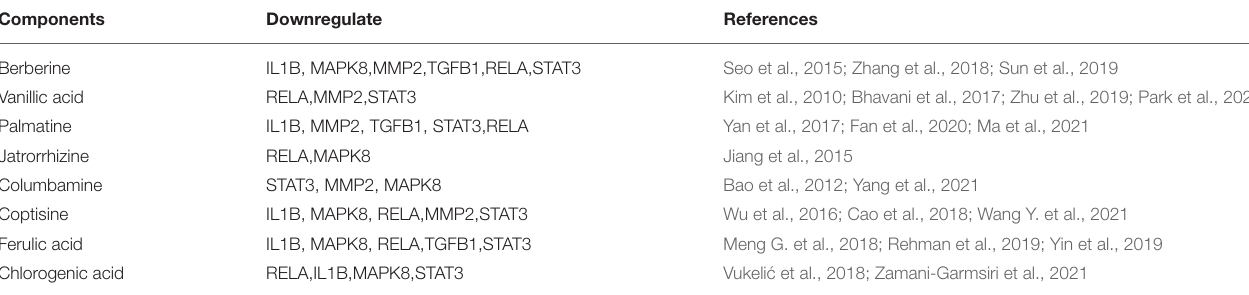
TABLE 5 | Analysis of chemical constituents and core targets regulation of